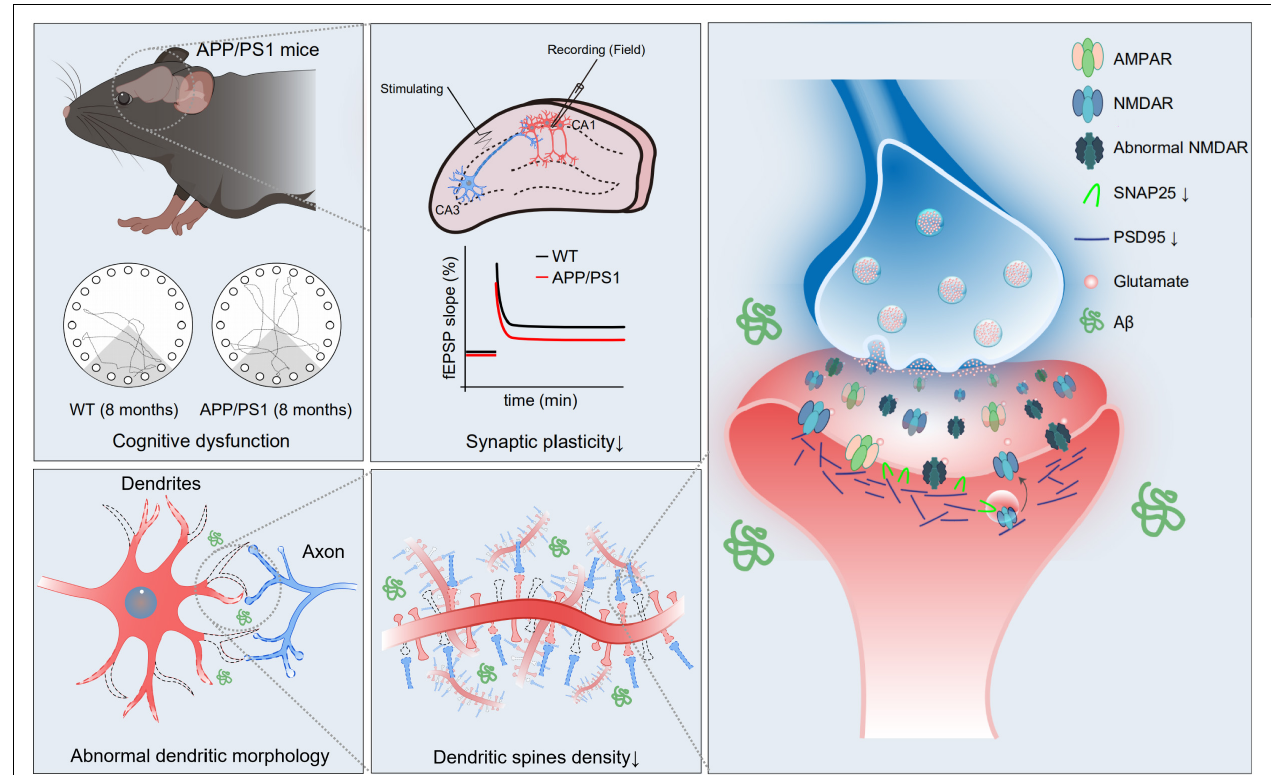
FIGURE 7 | Schematic diagram of the mechanism of cognitive impairment in 8-month-old APP/PS1 mice. In hippocampal CA1 area of APP/PS1 mice, impaired function of NMDAR, reduced expression of synaptic proteins, abnormal neuronal morphology, and decreased dendritic spine density may give rise to weak synaptic plasticity, which mediates age-related cognitive